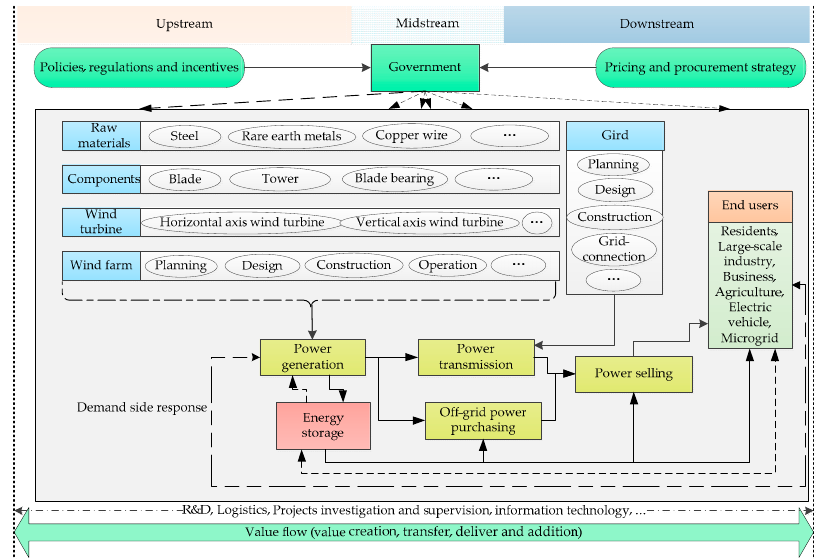
Figure 4. Annual and cumulative installed capacity of wind power in China [8,17,53]. Appl. Sci. 2018 , 8 , x FOR PEER REVIEW